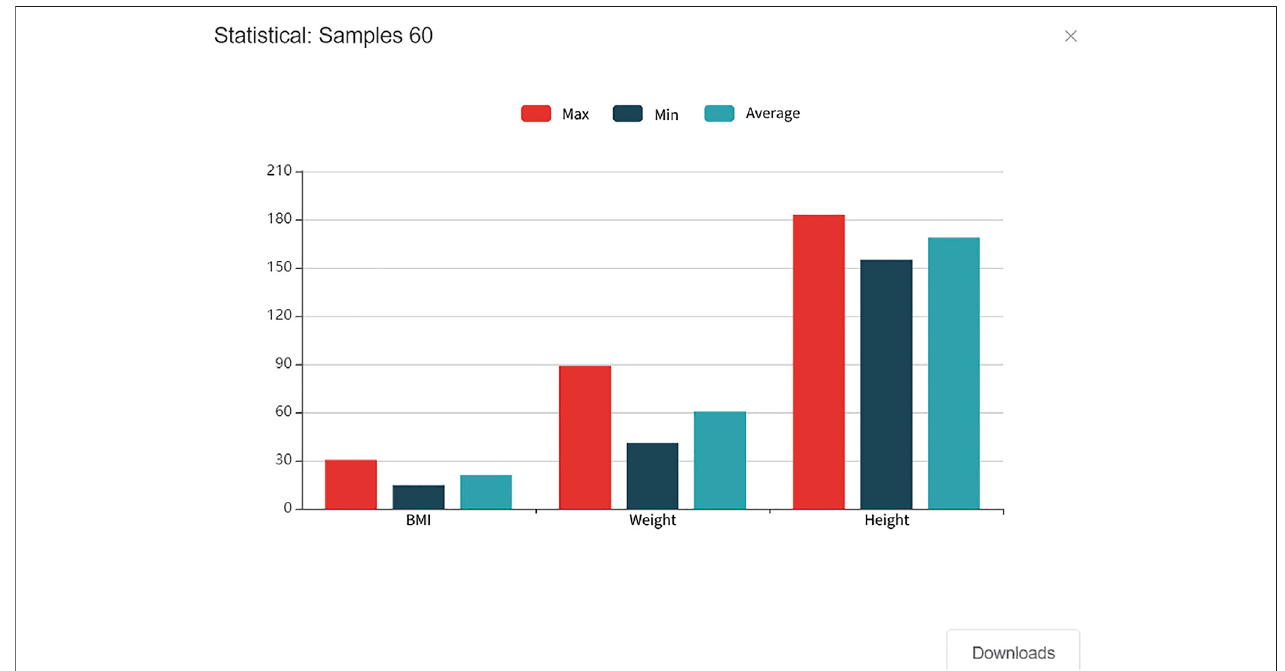
FIGURE 8 | Aggregate statistical result for personal health data. Data from multiple parties would be delivered to the trusted computing environment on a central server in which aggregate statistical analysis would be performed.